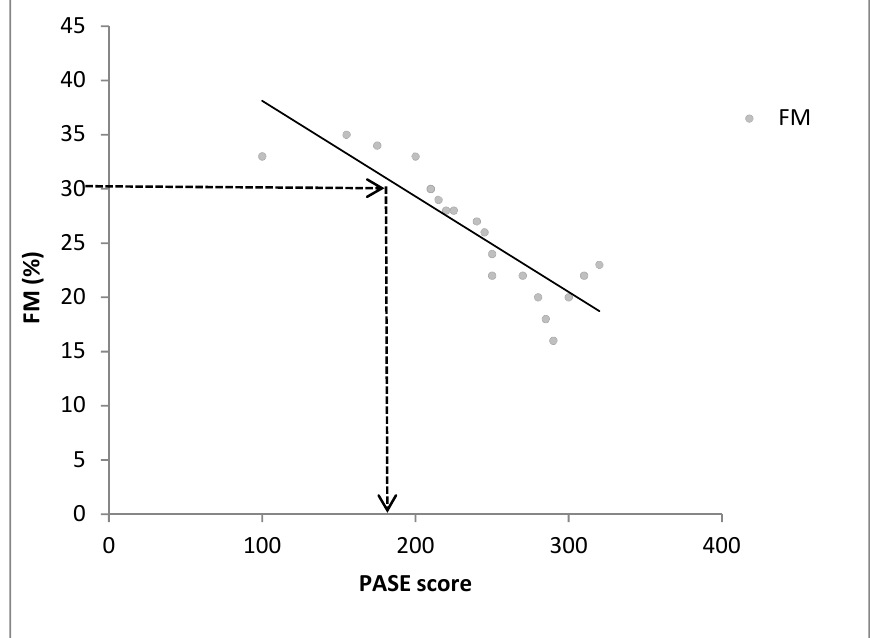
FM = fat mass; PASE = physical activity scale for the